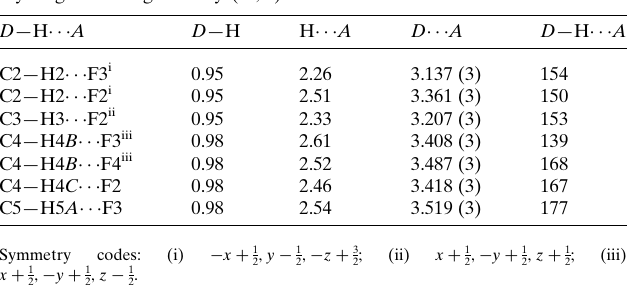
Table 1 Hydrogen-bond geometry (A˚ , (cid:4) ) for 1 .